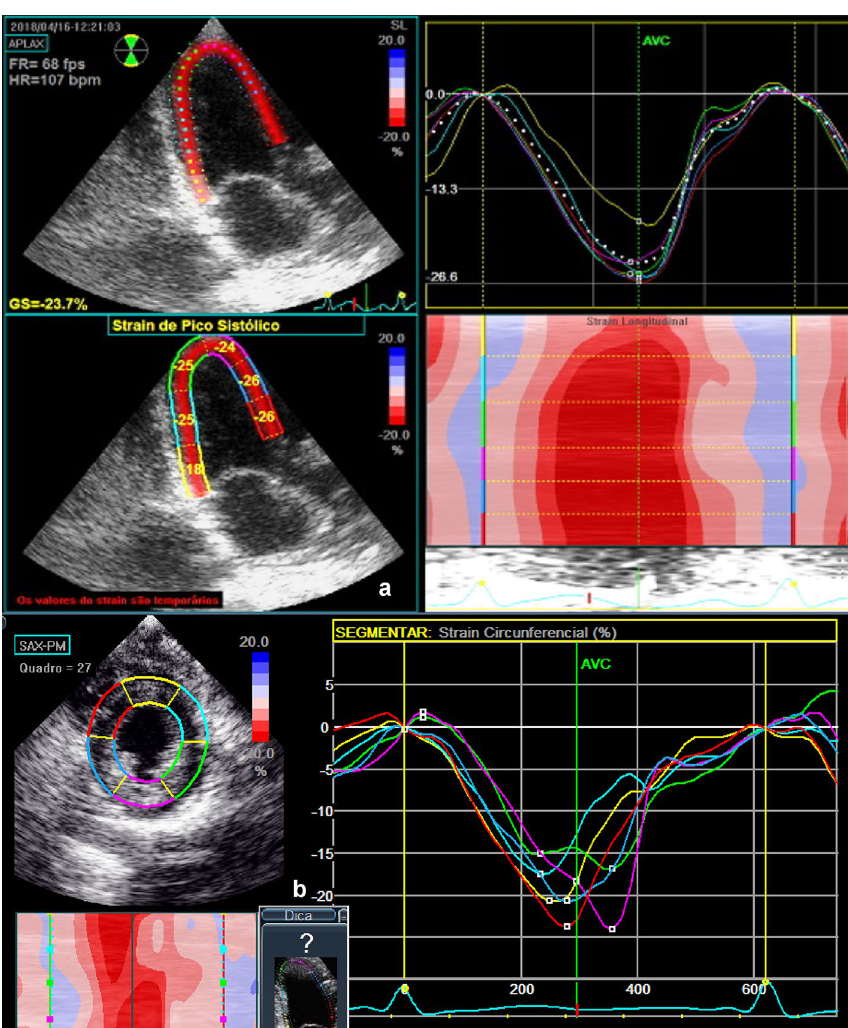
Figure 1. Two-dimensional speckle tracking echocardiogram. ( a ) Apical 3 chamber view, and ( b ) parastenal short axis view at the level of the papillary muscles.